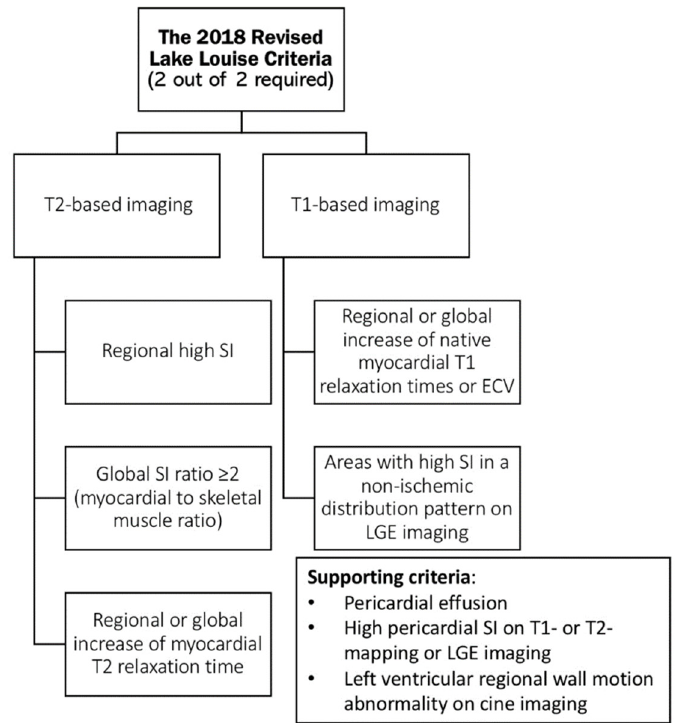
7 of 21 Table 2. A comparison between standard versus novel CMR techniques showing a higher sensitiv- ity of T1, T2, and ECV mapping compared to the standard CMR techniques. Technique Sensitivity (%) Specificity (%) Standard CMR